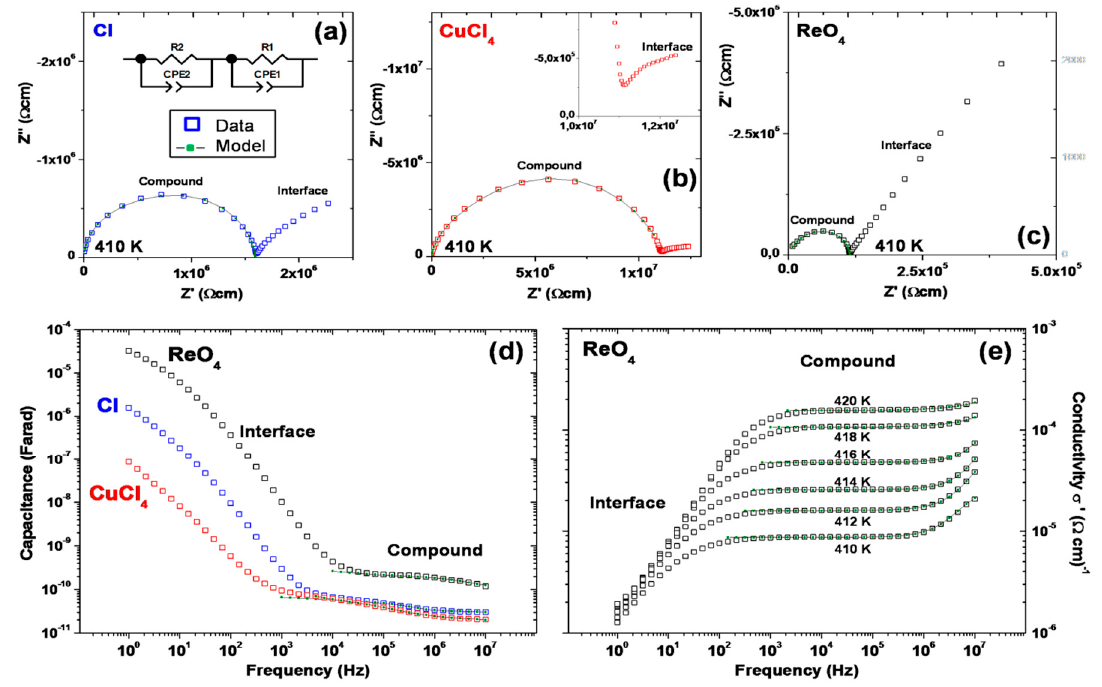
Figure 6. ( a – c ) Z ″ vs. Z ′ and ( d ) C ′ vs. f plots for the Cl − , CuCl 42 − and ReO 4 − salts; ( e ) σ′ vs. f plots for